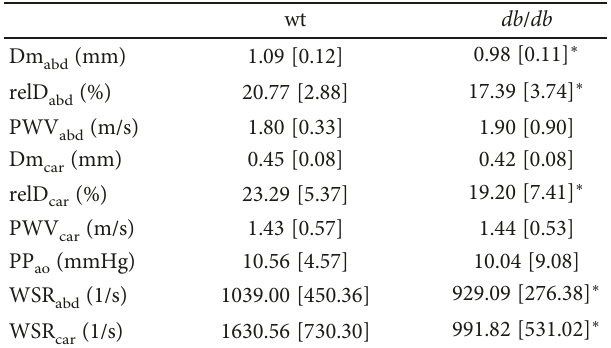
Table 3: Ultrasonographic vascular parameters in the two groups of mice.